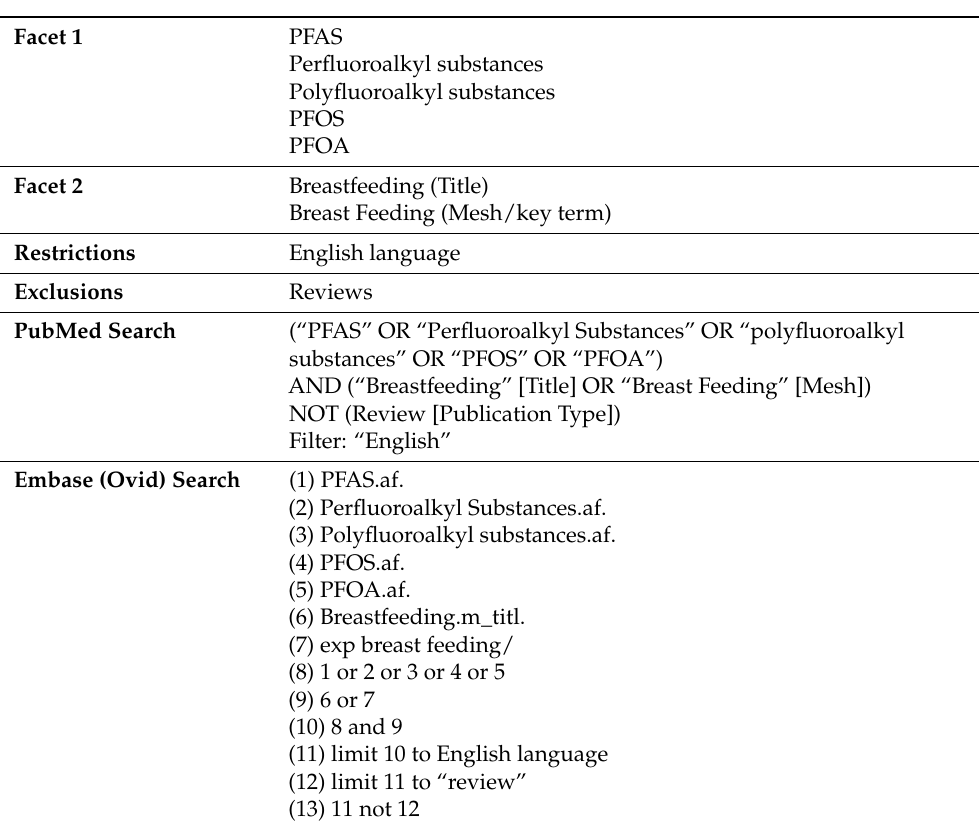
Table 1. Search strategy.